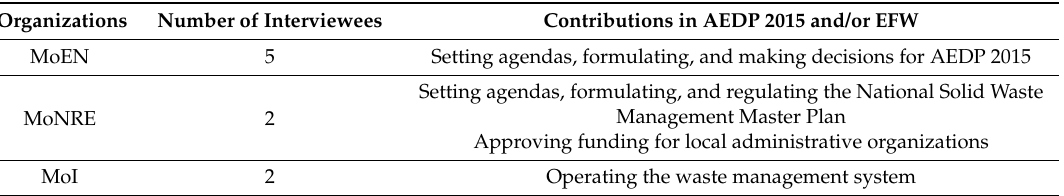
Table 3. Organizations, number of informants, and their contribution in policy